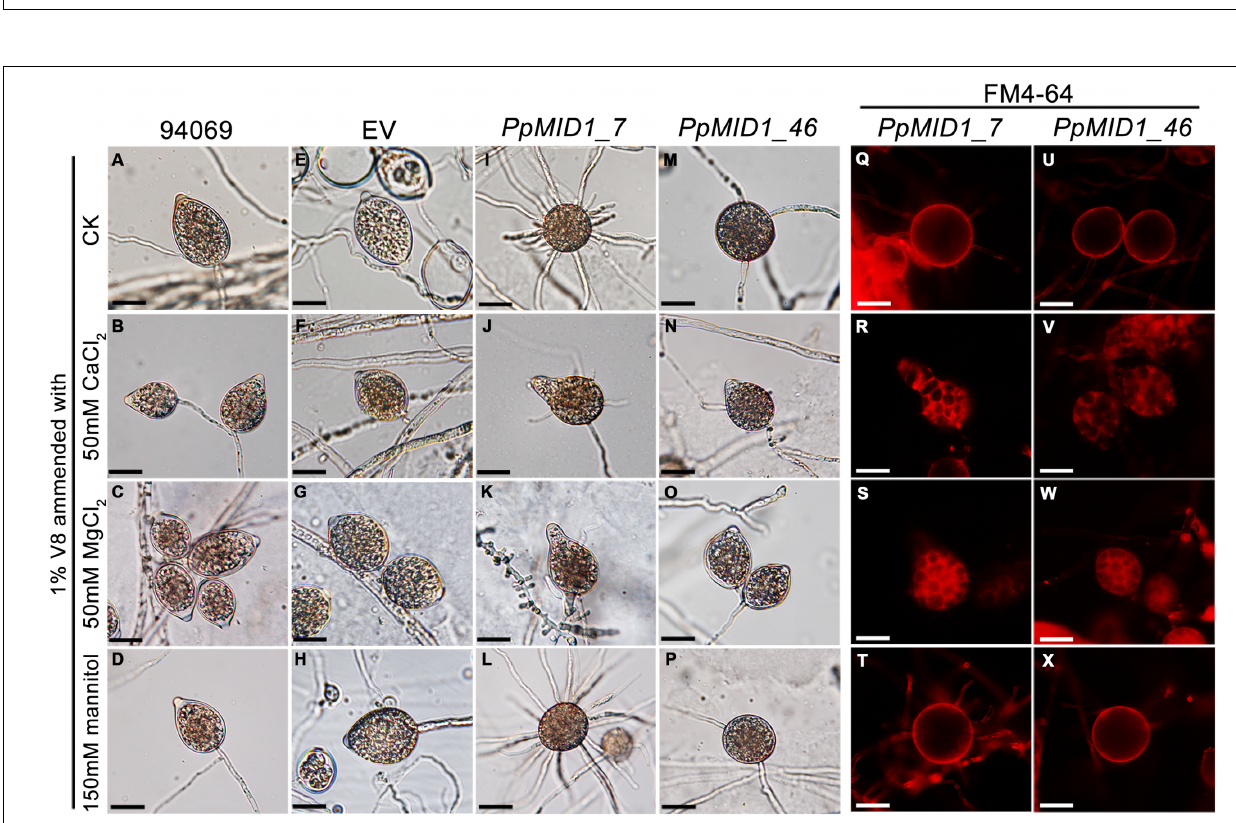
FIGURE 7 | Addition of CaCl 2 or MgCl 2 restores the defective sporangia in PpMID1- silenced transformants. Mycelial blocks of PpMID1_7 and PpMID1_46 , EV, and wild-type Phytophthora parasitica (94069) were incubated in 1% V8 juice medium with the indicated reagents under light at 25 ◦ C for 3 days to induce sporangium formation. As a control, sporangia were induced in 1% V8 juice medium without any amendment (ck). The sporangia were then subjected to cold shock at 19 ◦ C for 30 min and stained with FM 4–64 to examine cytoplasmic cleavage. (A–P) : Morphology of sporangia produced by the wild type (94069; A–D ), EV (E–H) , PpMID1_7 (I–L) , and PpMID1_46 (M–P) . (Q–X) : cytoplasmic cleavage in sporangia produced by PpMID1_7 (Q–T) and PpMID1_46 (U–X) . Bar = 20 µ m.